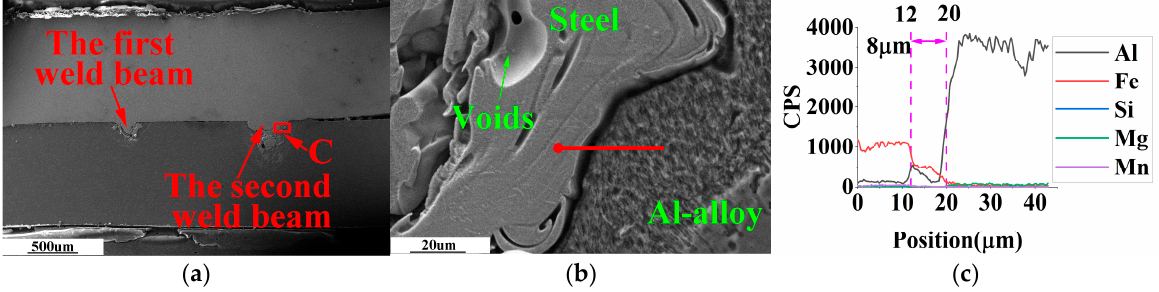
Figure 11. SEM-EDS observation of weldment with weld spacing of 1.5 mm. ( a ) Main areas of weld cross-section; ( b ) enlarged view of area C in Figure 11a; ( c ) EDS line scan results of the red line in Figure 11b.